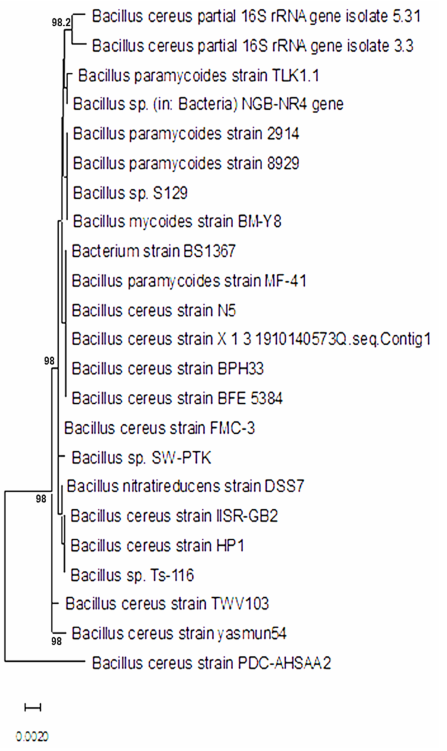
Figure 2. Phylogenetic dendrogram showing the position of Bacillus cereus strain PDC-AHSAA2 among phylogenetic neighbors.